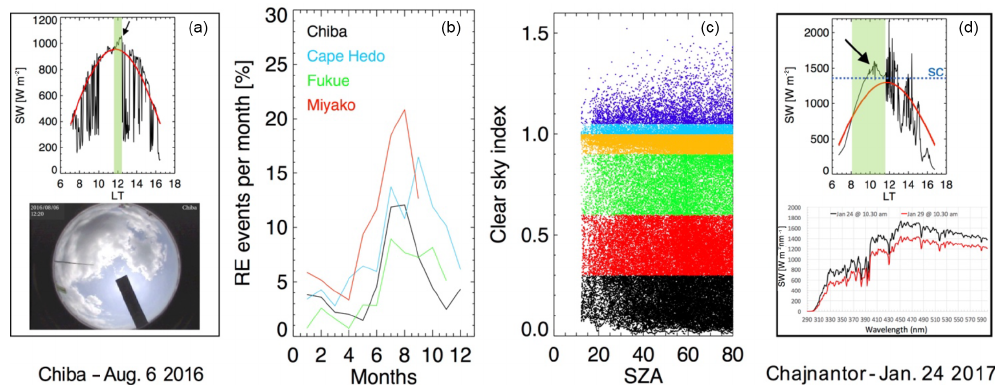
Figure 5. (a) Downwelling global shortwave radiation (SW) measurements (black line) and clear-sky simulation (red line) at the Chiba station on 6 August 2016 (top panel). An example of a radiation enhancement (RE) event lasting about 40min (green shadow) is indicated by the black arrow and also shown in the all-sky camera image below around the peak of the event (bottom). (b) Percentage of RE events per month among total monthly samples for the different SKYNET stations. (c) Clear-sky index (CSI) and solar zenith angle (SZA) at the Chiba station. (d) Global SW measurements (black line) and clear-sky simulation (red line) at the Chajnantor station (Chile) on 24 January 2017. The arrow indicates an RE event lasting about 3.5h (green shadow); the horizontal dotted line indicates the solar constant (top panel); spectral SW measurements recorded at the Chajnantor station at 10:30 on 24 January (i.e., around the peak of the RE event; black line) and under clear-sky conditions on 29 January 2017 (red line; bottom